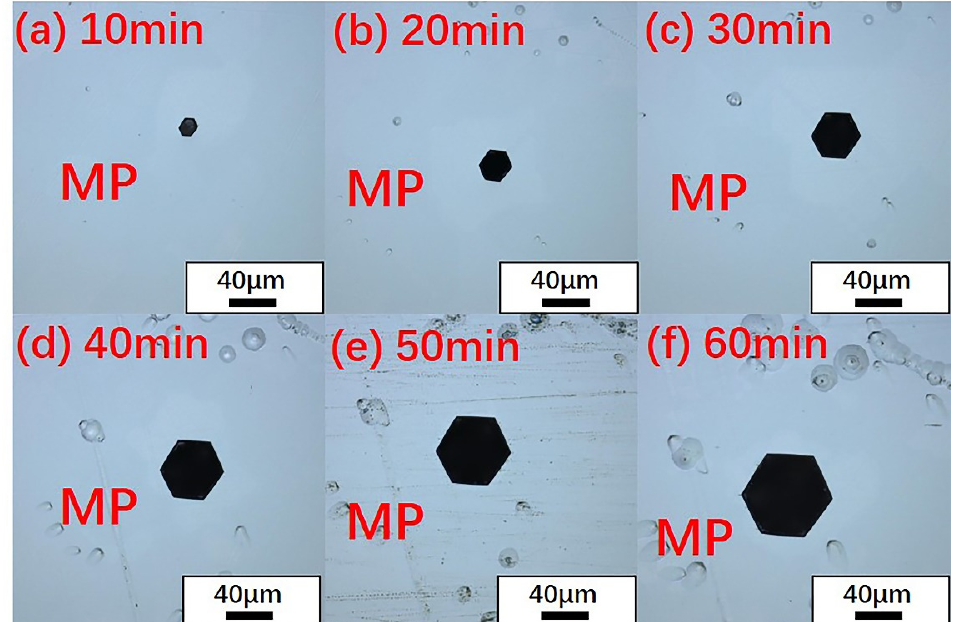
Figure 4. Evolution of the morphology of micropipe etch pits with time under a laser confocal microscope. ( a ) 10 min, ( b ) 20 min, ( c ) 30 min, ( d ) 40 min, ( e ) 50 min, ( f ) 60 min.